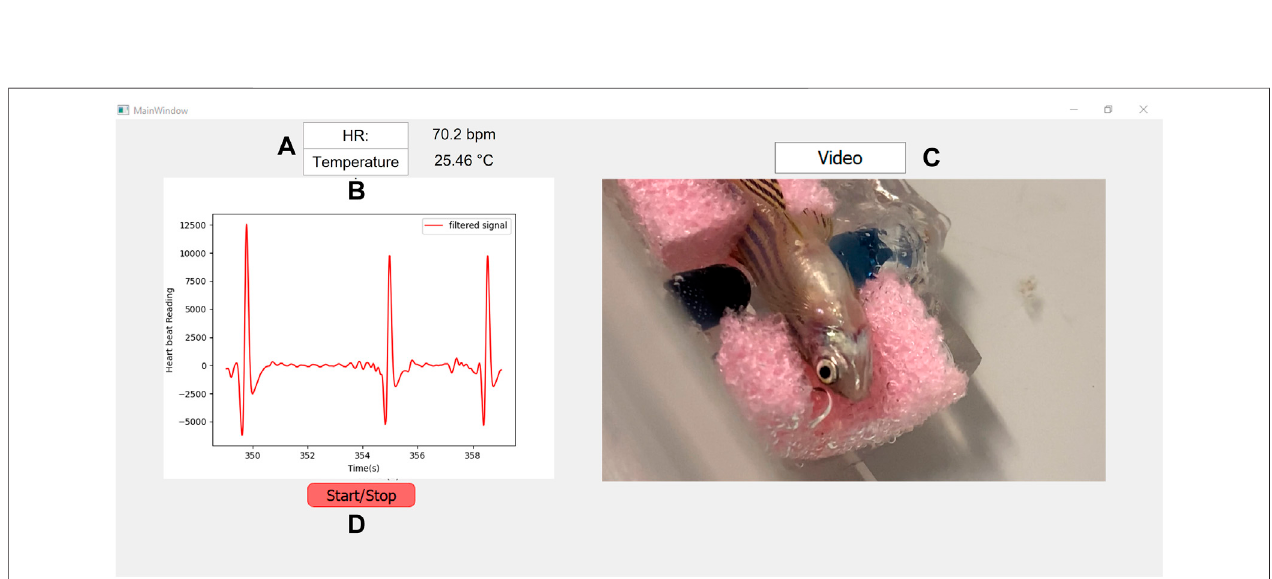
Frontiers in Physiology |